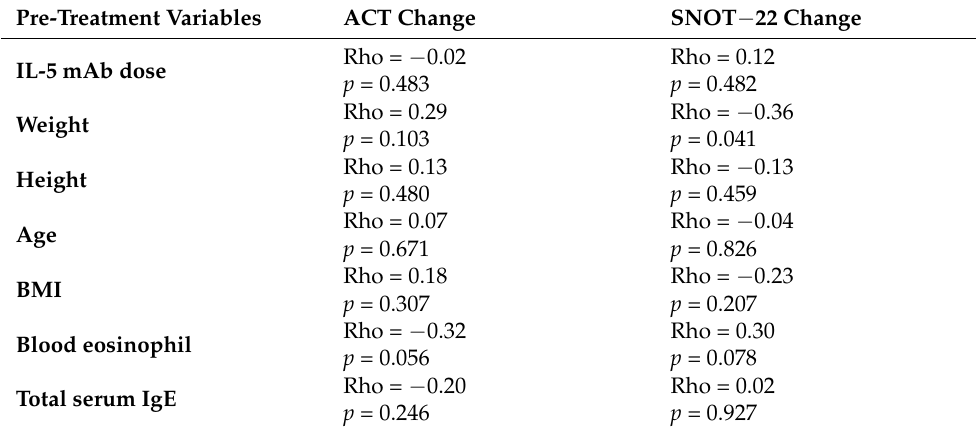
Table 2. Predictors of clinical response.